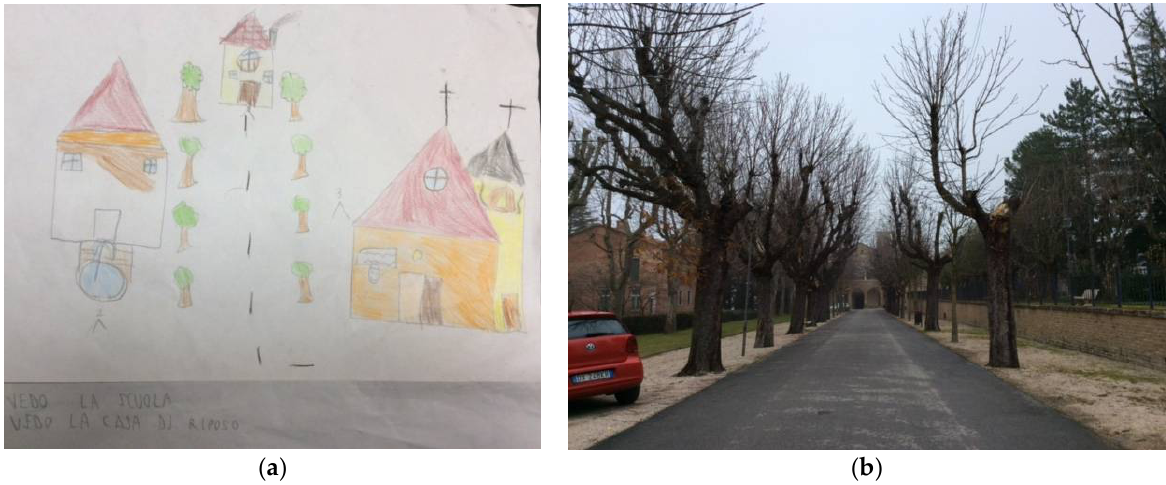
Figure 8. Gualdo, the boulevard Vittorio Veneto. ( a ) A bird’s eye view of the boulevard (drawing Vanessa, who was attending the second class of the elementary school). ( b ) The long tree-line boulevard direction to the hospice. The trees seem taller because of the point of view’s